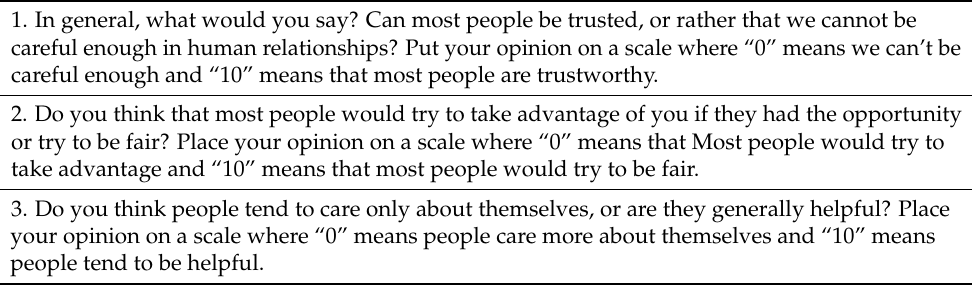
Table A3. The three items in the questionnaire measuring personal trust.